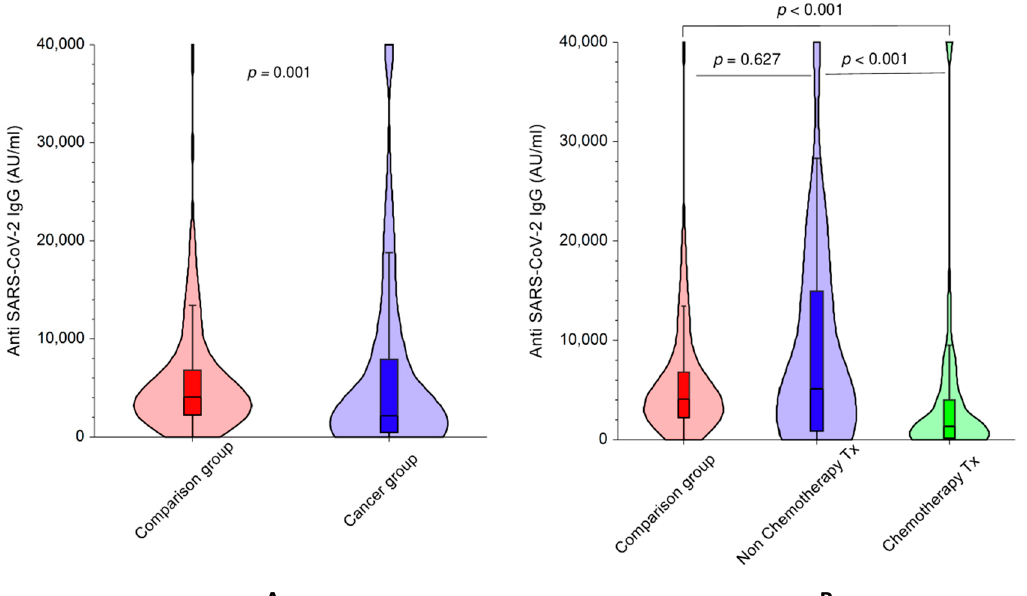
A B Figure 2. SARS-CoV-2 IgG antibodies titer. Violin graphs and box plots of the distribution of anti-SARS-CoV-2 antibody levels (AU/mL). The median and quartiles are presented as horizontal lines within the box plot. ( A ) Cancer and comparison non-cancer groups (unmatched). The median SARS-CoV-2 IgG levels, (2231 AU/mL) were significantly lower in the cancer group than in the comparison group, median 4100 AU/mL, ( p = 0.001). The lower IgG values are more frequent in the cancer group; ( B ) chemotherapy-treated, non-chemotherapy-treated and comparison groups (unmatched). The lower IgG values, as apparent from the wider bottom distribution, are more frequent in the chemotherapy treated group. The antibody levels in the chemotherapy group, median 1361 AU/mL, but not in the non-chemotherapy group, median 5088 AU/mL, are significantly lower than the comparison group, median 4100 AU/mL, p < 0.001 and p = 0.627 respectively. Median immunoglobulin levels, represented by the middle horizontal lines, were significantly lower in the chemotherapy-treated patients: 1361 AU/mL versus 5088 AU/mL in non-chemotherapy treated patients ( p < 0.001). Table 2. SARS-CoV-2 mRNA Vaccine Response after the second dose.